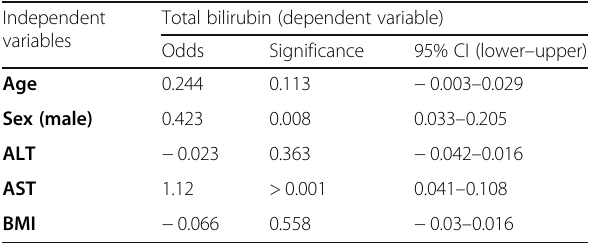
Table 4 Multiple linear regression analysis between age, gender, liver functions, and total bilirubin in cases of migraine Independent